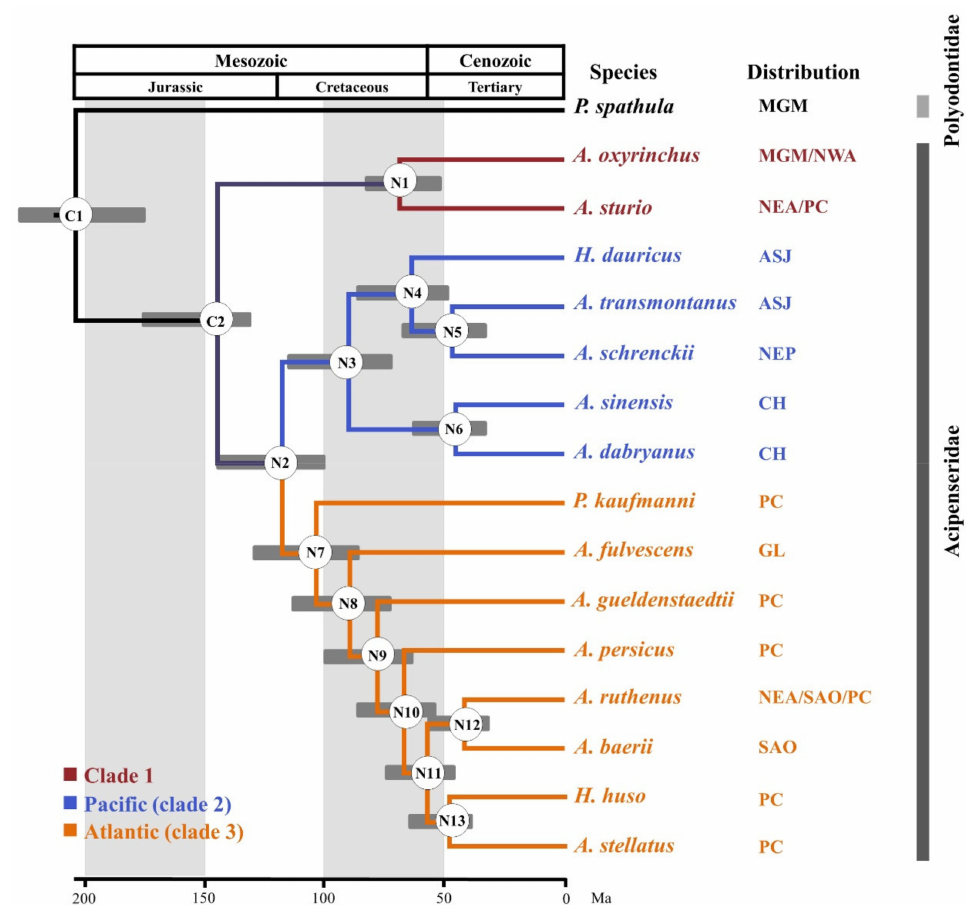
Figure 3. Timetree of 16 Acipenseriformes species. The node number represents the corresponding number. C1 and C2 are calibration nodes. N1–N13 indicate the nodes of interest for which estimated dates are presented in Table S8. CH: China; ASJ: Amur River, Sea of Okhotsk, Sea of Japan; NEP: Northeast